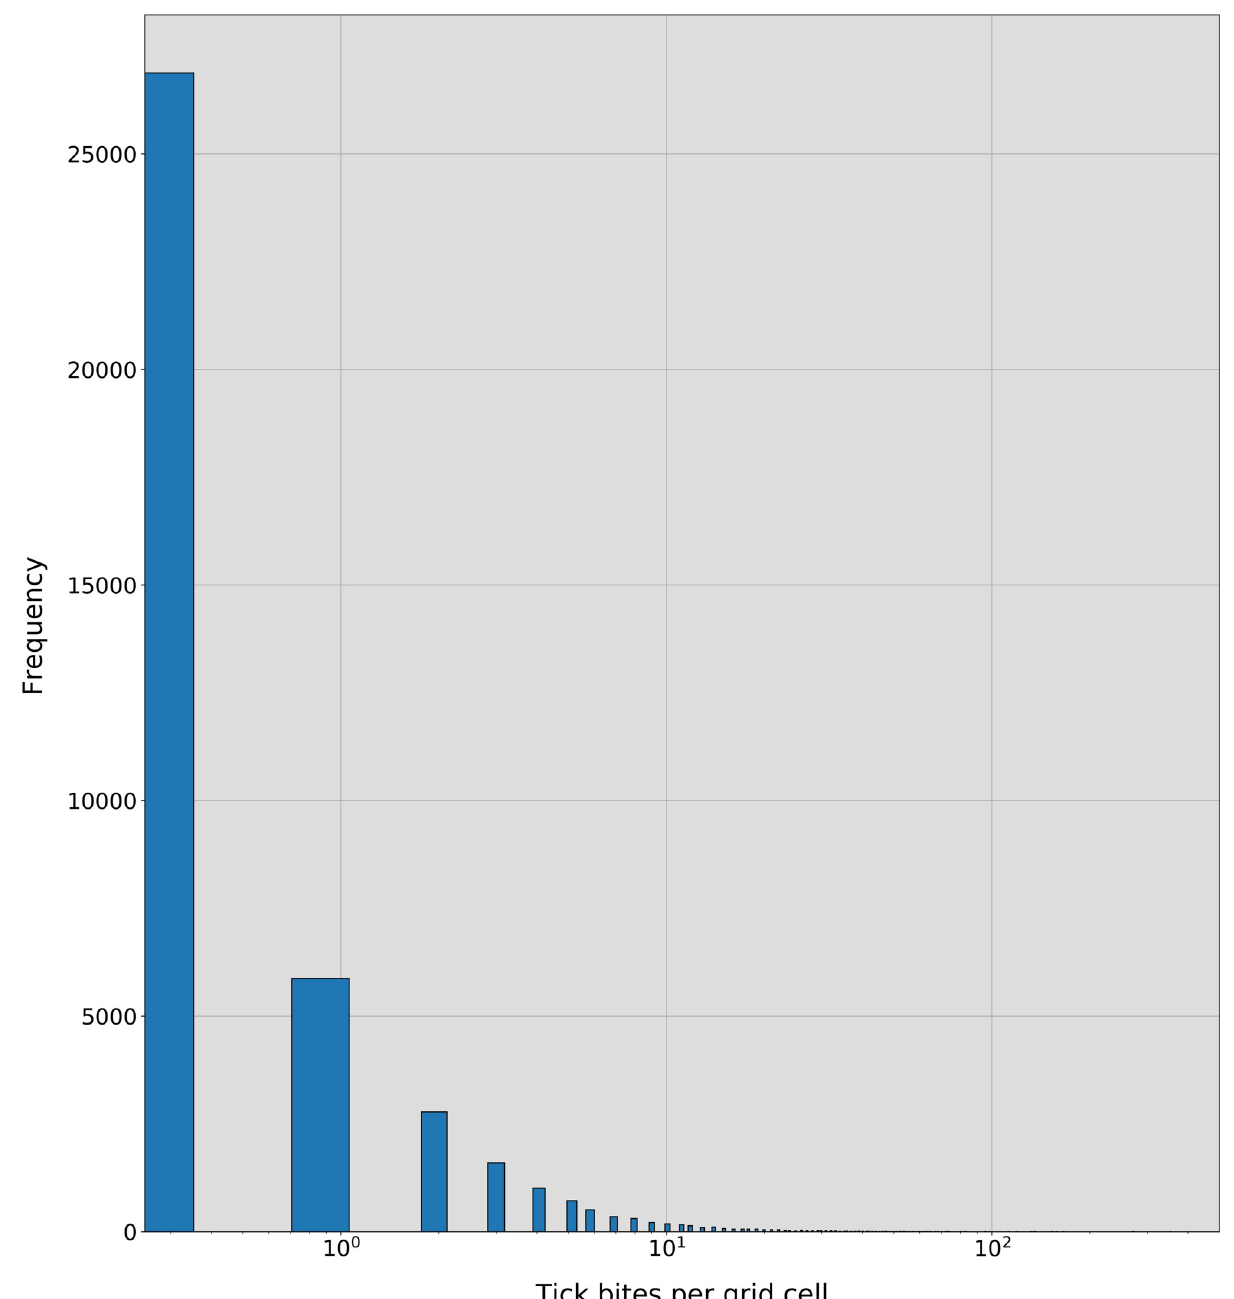
Fig 3. Histogram of the tick bites per grid cell. As seen, after the process of spatial aggregation described in Section 3.1, a skewed distribution with zero-inflation is created. Note that the X-axis is represented in log-scale to ease the visualization of the distribution. The number of grid cells containing more than 30–40 tick bite reports is almost negligible, but the distribution spans until a maximum of 353 tick bites per